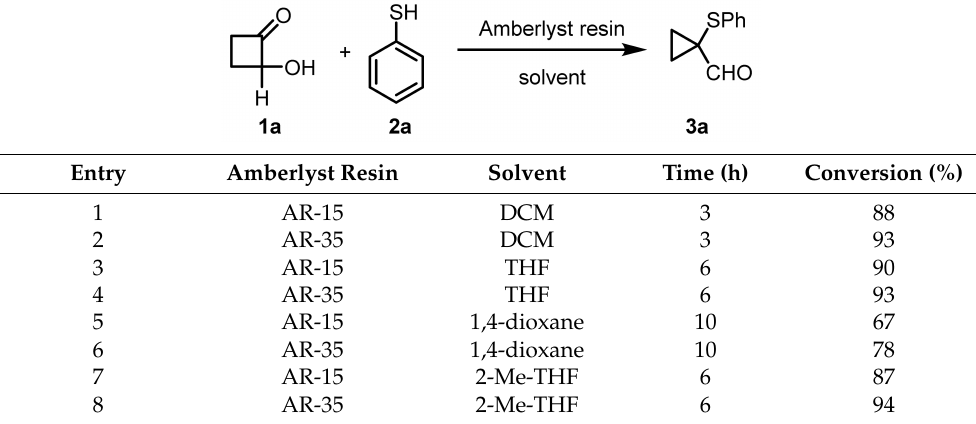
Table 1. Catalyzed synthesis of aldehyde 3a. Reactions were carried out at room temperature in a 5 mL and the indicated solvent (conc. 0.1 M). Conversion of 3a was determined by GC-MS